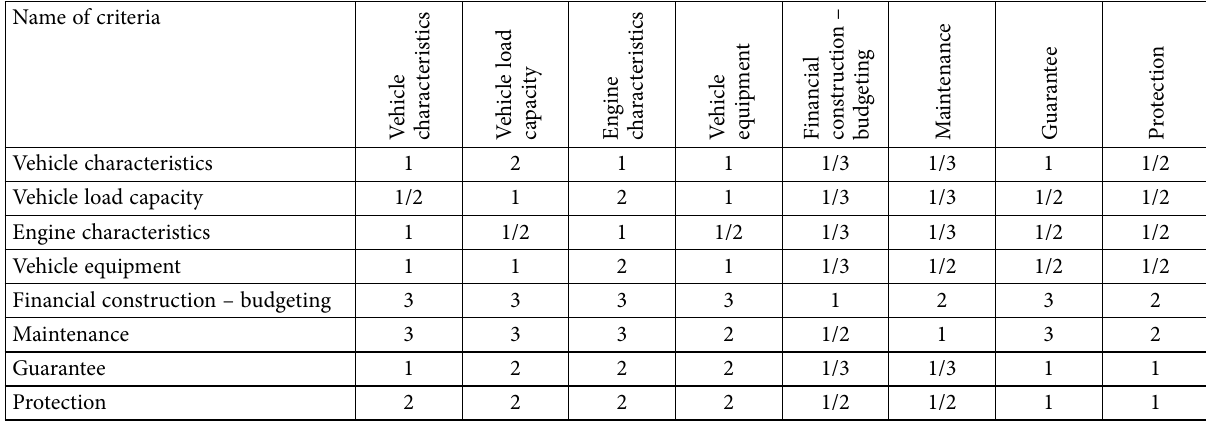
Table 3. Weight criteria comparison